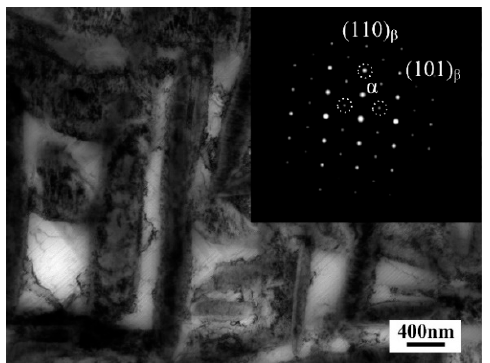
Figure 9. TEM micrograph of the alloy aged at 600 °C for 4 h and corresponding electron diffraction pattern.